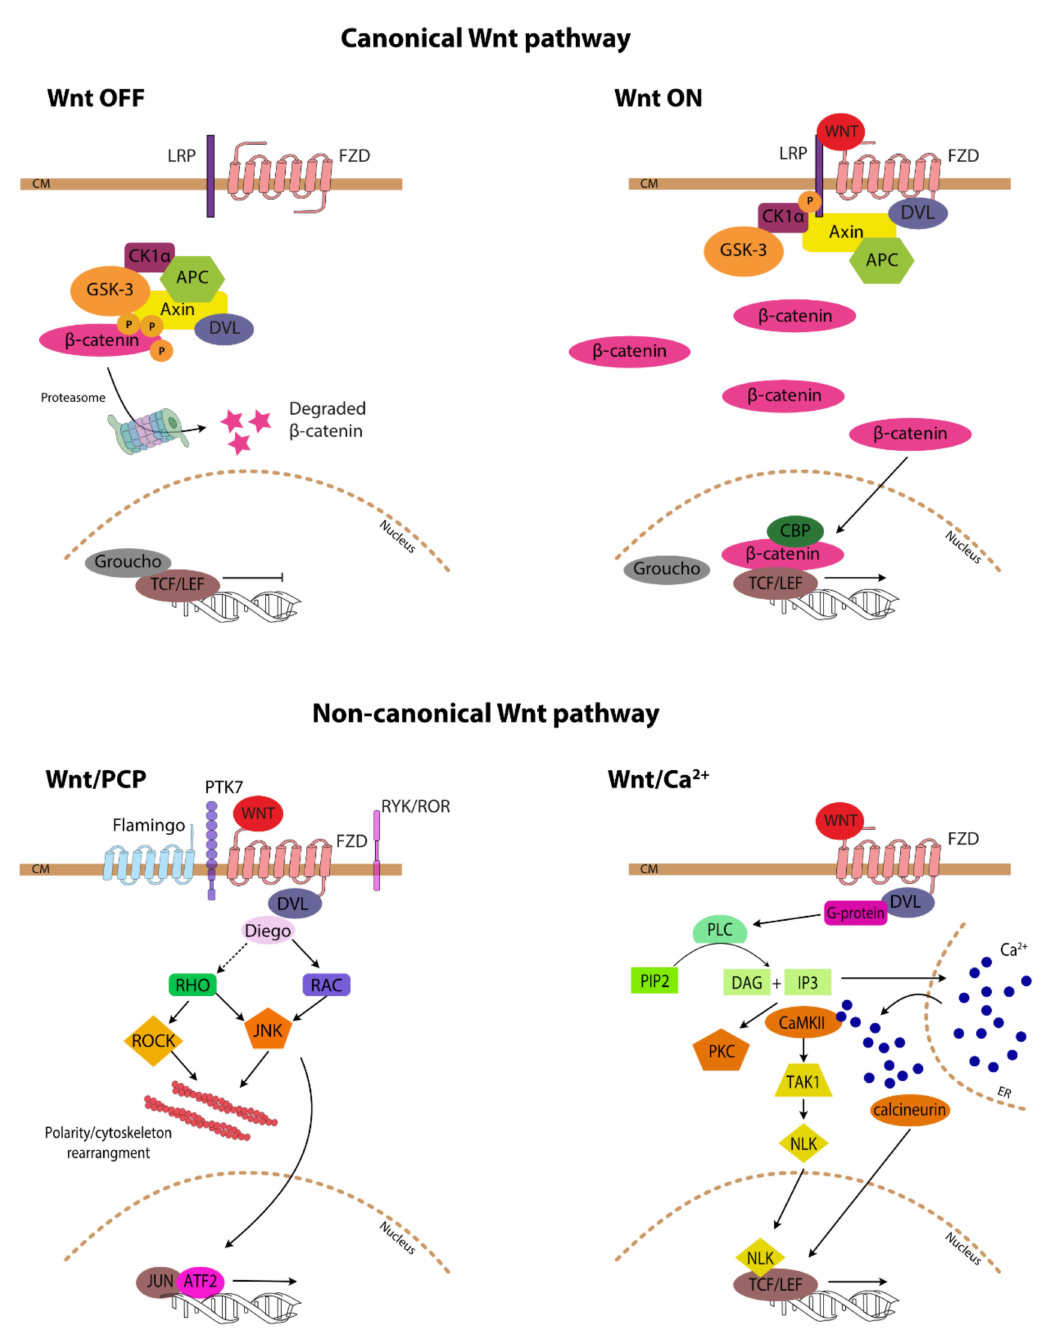
Figure 1. Canonical and non-canonical Wnt